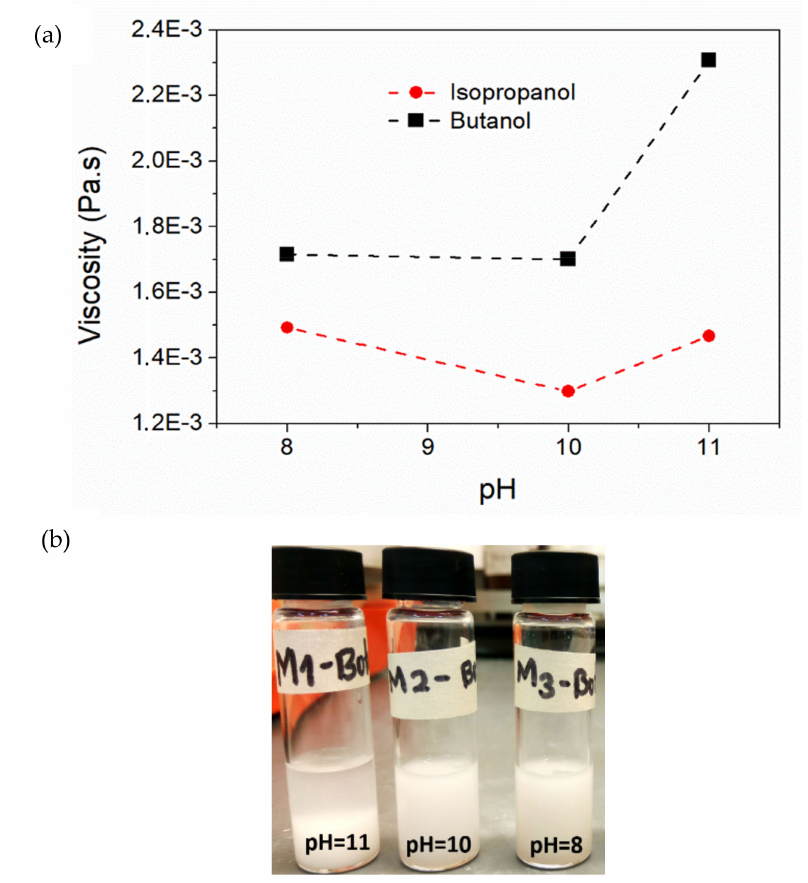
Figure 6. ( a ) Influence of polar solvent and pH on the viscosity of the Al 2 O 3 dispersions with a solid concentration of 20 mg / mL; ( b ) images of dispersions in butanol (left) and isopropanol